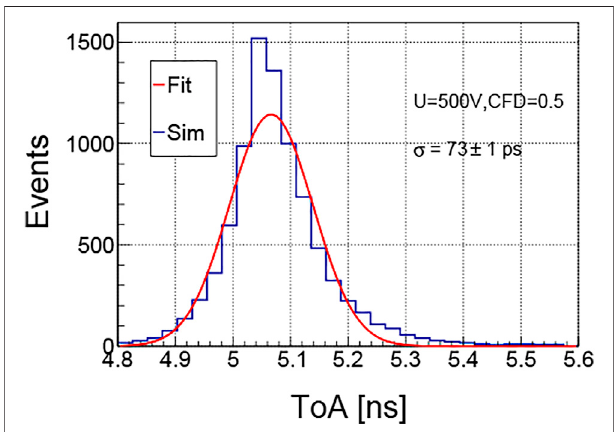
FIGURE 12 | (Color online) Time resolution simulation results of the 5 mm×5 mm size NJU